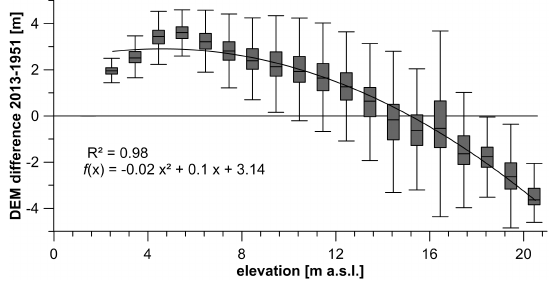
Figure 5. Elevation dependent bias in 2013–1951 raw DEM dif- ference and correction using an empirical function of second order